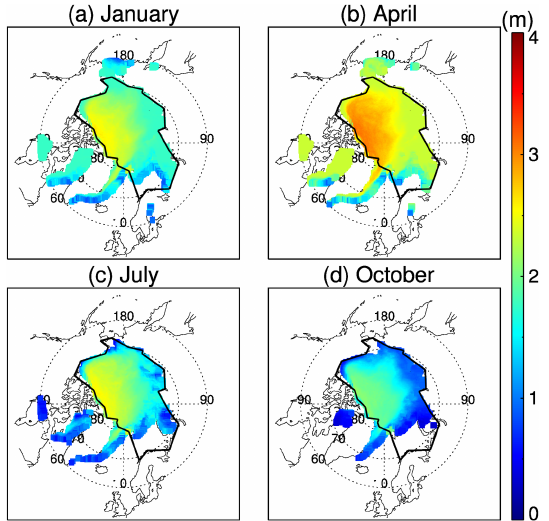
Figure 13. Monthly mean sea ice thickness distribution 1984 to 2018 from ice age in the Arctic in January, April, July, and Oc- tober. The polygon outlines the Arctic Ocean defined in this study, as in Kwok (2018).